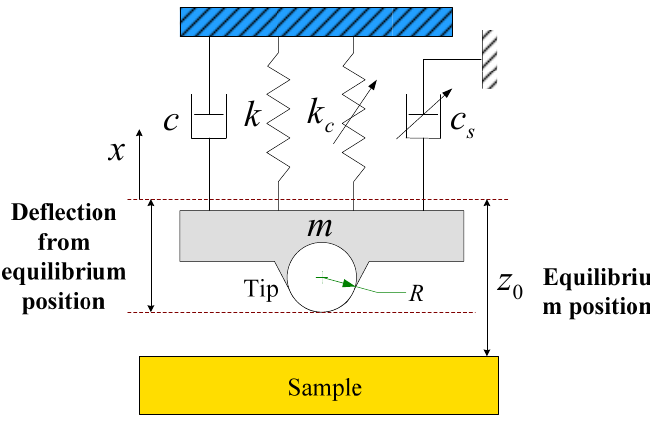
Figure 2. Schematic of the lumped spring-mass-damping model for the TM-AFM cantilever vibrating near a sample